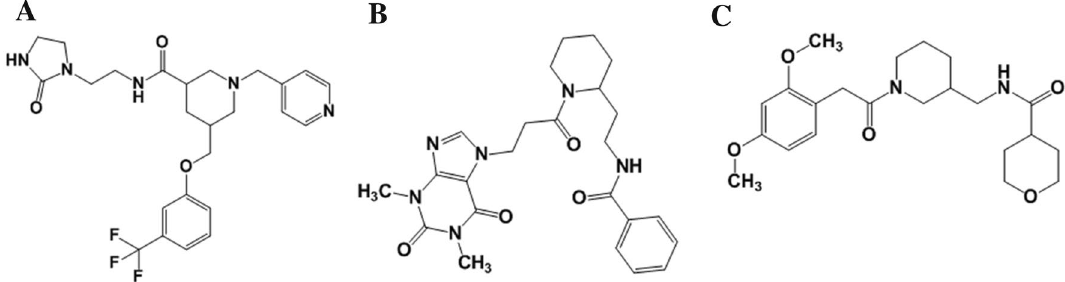
Figure 11. The 2-D structures of screened hit compounds. The figure is drawn using ChemDraw Ultra